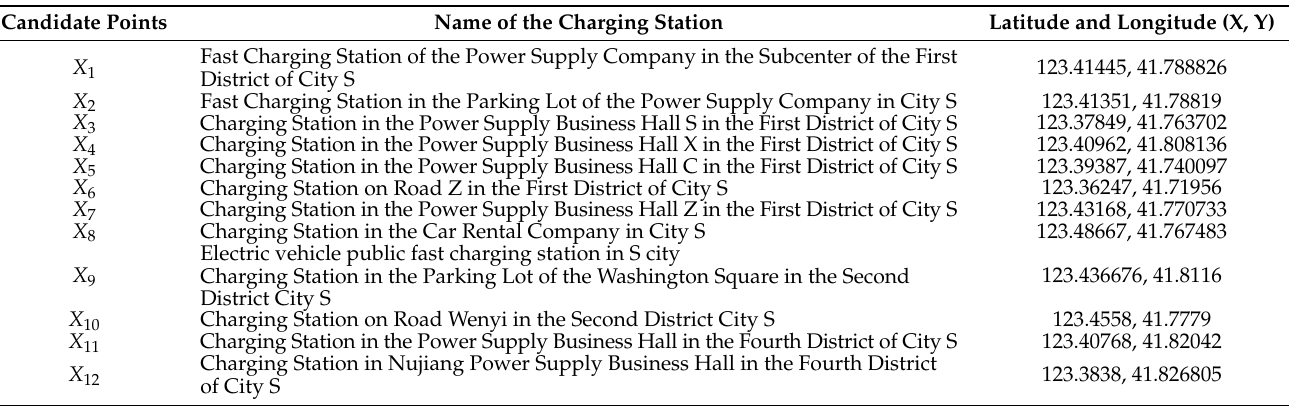
Table 7. Coordinates of candidate points.